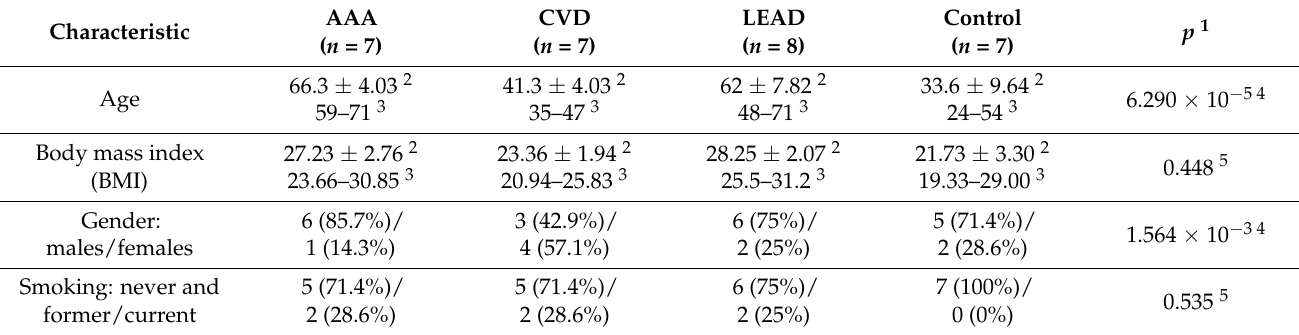
Table 1. Clinical attributes of the study